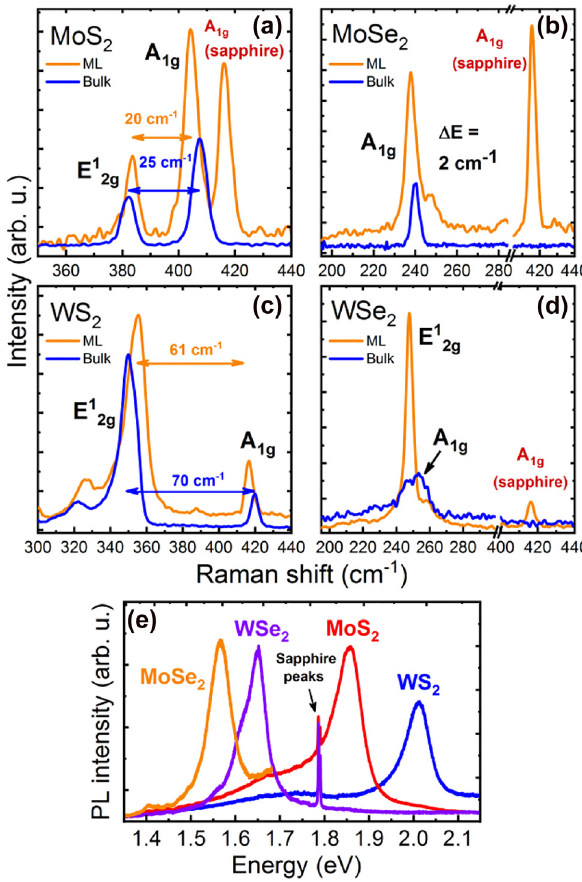
Figure 1: Comparison of room temperature Raman scattering of monolayer (ML) and bulk TMDs (a) – (d) and photoluminescence spectra of ML TMDs (e). Sharp emission peaks at 694 nm ( ∼ 1.79 eV) originate from the sapphire substrate, common for all MLs.